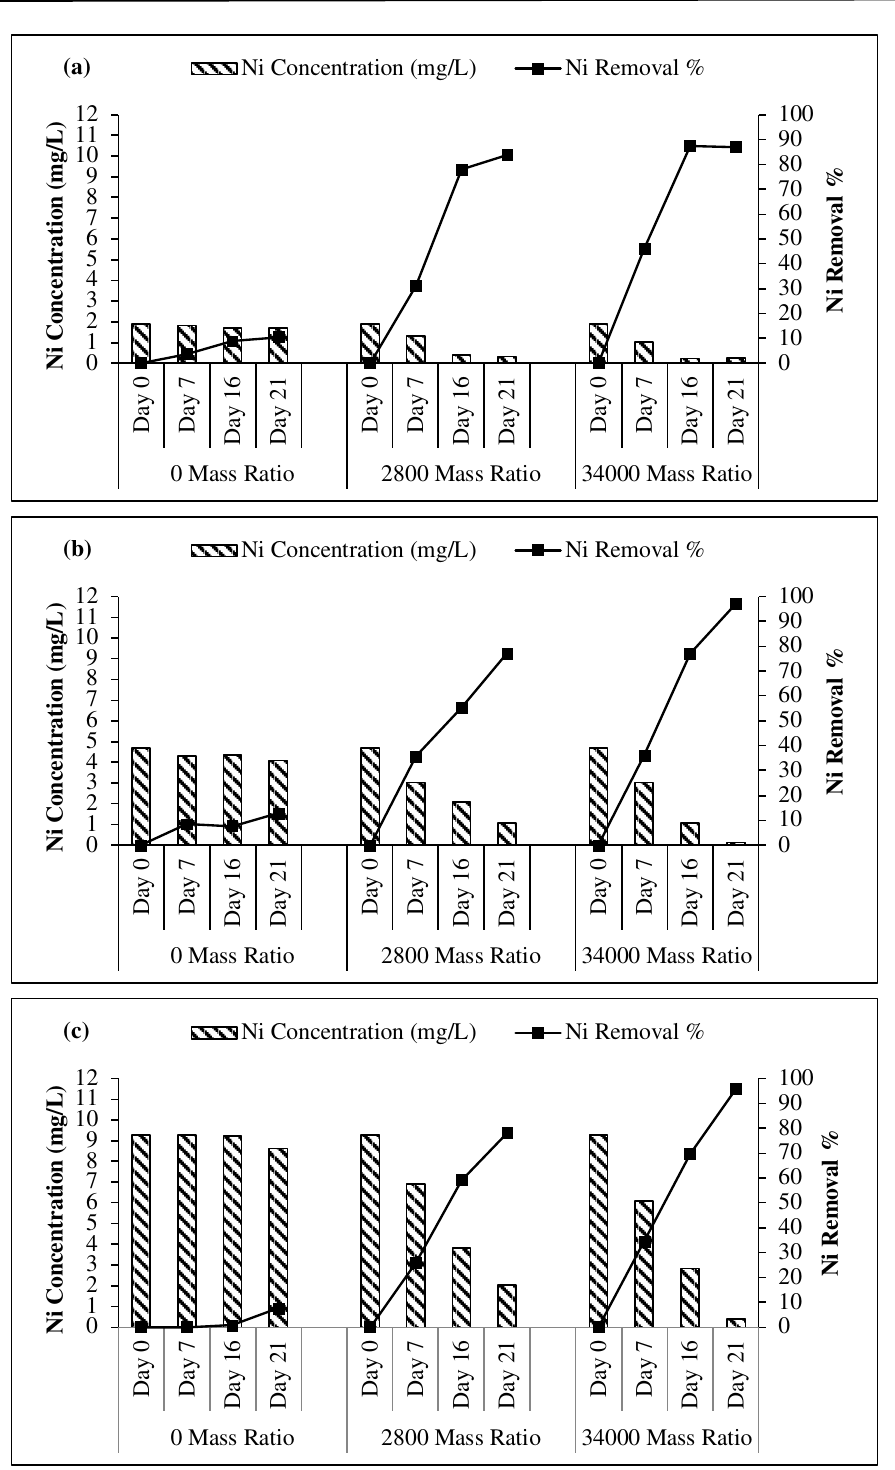
Fig. 3. Ni concentrations and removal percentage by Iresine herbstii during 21 day and mass ratio (0, 2800, 34000) (a) 2 mg/L, (b) 5 mg/L and (c) 10